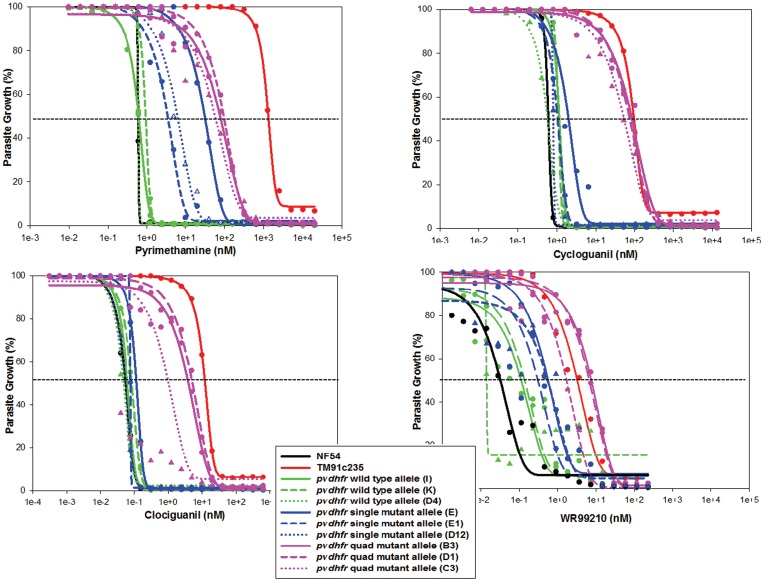

In vitro susceptibility of P. falciparum NF54 and integrated parasite clones stably expressing various pvdhfr mutants to DHFR inhibitors: pyrimethamine (top left panel), cycloguanil (top right panel), clociguanil (bottom left panel), and WR99210 (bottom right panel).Each color represents a pvdhfr allele and lines of the same color represent different clones of the same expressed pvdhfr allele. The symbols represent the means of triplicate data points.